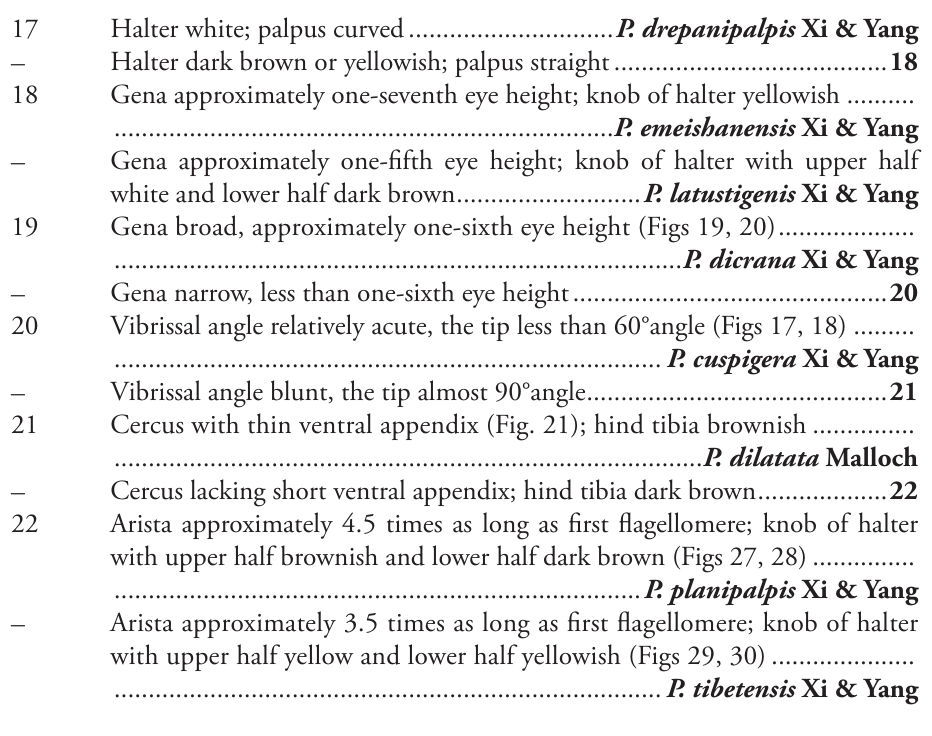
Diagnosis. Gena approximately one-fourteenth of eye height. Upper blade of bifur- cated tip of surstylus swollen and apical margin rounded, lower blade thin and longer than upper one; cercus arched with short sparse setae. Head (Fig. 1) black with greyish microtomentum; orbital plate satiny blackish brown, with microtomentum, ocellar triangle blackish brown without microtomentum; lunule very depressed falciform, darkish brown with black margin. Posterior eye margin ventrally diverging from head margin; eye 1.4 times as high as long, gena approximately one-fourteenth of eye height. Setae and setulae on head black; ocellar triangle with two ocellar setae and three short setae; frons with three orbital and two frontal setae on black- ish brown orbital stripe, orbital setae lateroclinate and frontal setae medioclinate, four interfrontal setae; postocellar setae cruciate. Lunule with two setae. Vibrissal angle flat, the tip a little more than a 90°angle; vibrissa strong, located below level of lower margin of eye. Antenna darkish brown pedicel with short black setulae at middle and margin, setulae at margin longer than others, longest one approximately five times longer than others; first flagellomere with pubescence, irregularly oblong; arista three times as long